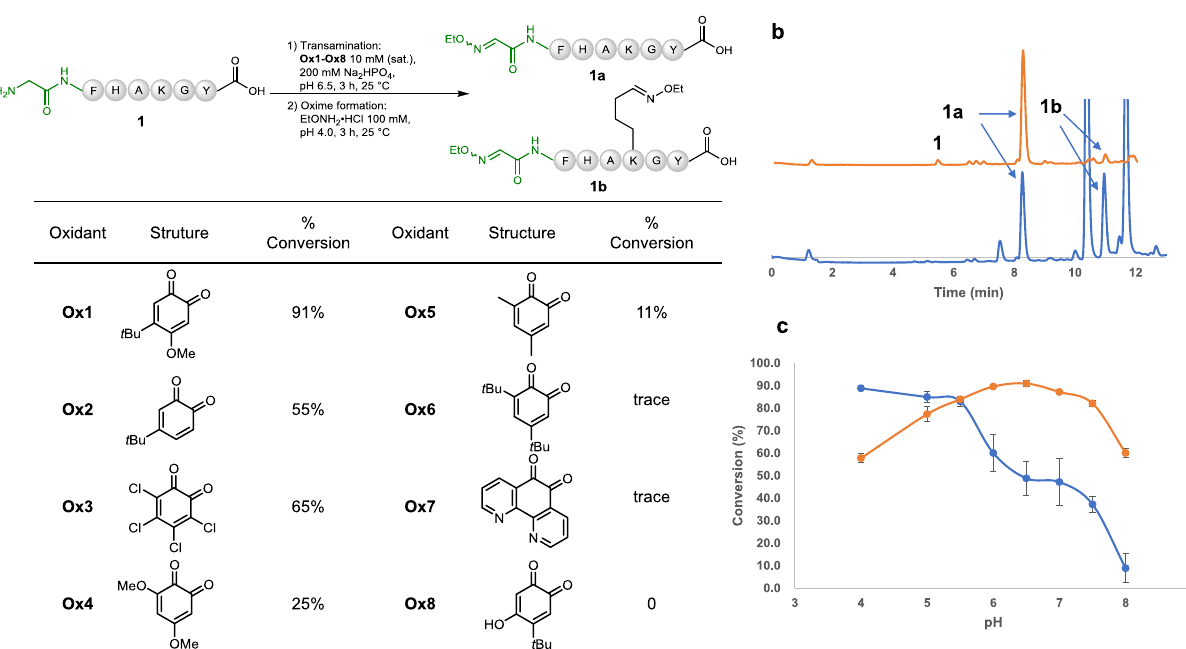
Fig. 2 Optimization of the reaction conditions used in the biomimetic transamination reaction. a Screening of oxidants Ox1-Ox8 used for the transamination reaction with model peptide 1 ; b LC trace obtained for the transamination reaction using Ox1 in yellow or Ox2 in blue; c pH Optimization of the transamination reaction using Ox1 in yellow or Ox2 in blue (the rate of conversion was calculated by integrating the related peaks of the LC trace measured at 280 nm. Centers represent means, error bars represent standard deviation, n = 3 independent